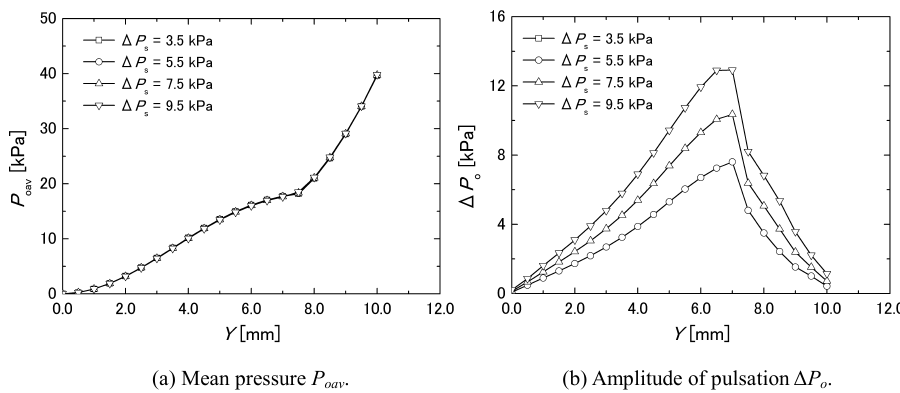
Fig. 8 Numerical reproduction of indentation experiment with four amplitude of supply pressure ∆ P s